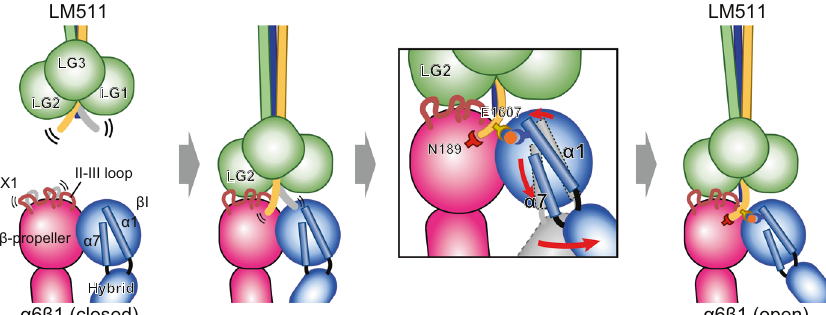
Fig. 7 Hypothetical model of the LM511 recognition by α 6 β 1 integrin. In the fi rst step, a long-range electrostatic search via the mobile and charged X1 region attracts the LG domain of laminin to integrin (the fi rst panel). The II-III loop fi xes the relative orientation between the integrin and laminin (the second panel). The fl exible γ 1-tail is fi xed via two anchor points (i.e., LM γ 1 P1609- α 6 N189 and LM γ 1 E1607-MIDAS), which induces local conformational rearrangement of α 1 and α 7 helices in the integrin β I domain, making the hybrid domain swing out (the third panel). Eventually, α 6 β 1 is converted into the extended-open conformation (the last